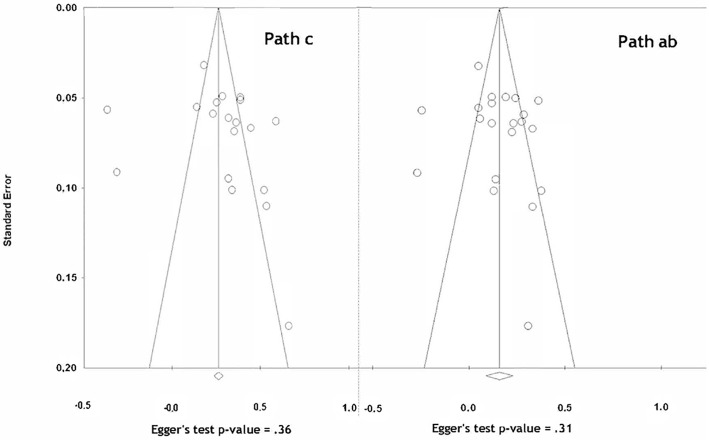
Funnel plots of correlations versus variance of correlations for total effect (path c) and indirect effect (path a*b).Left hand side: Funnel plot for the total effect (path c). Right hand side: Funnel plot for the indirect effect (path a*b). In both charts, Egger’s test p-value shows no publication bias (p > .05).